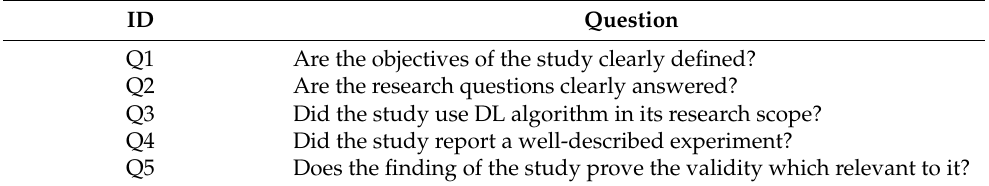
Table 4. Quality assessment on the articles based on the questionnaire.